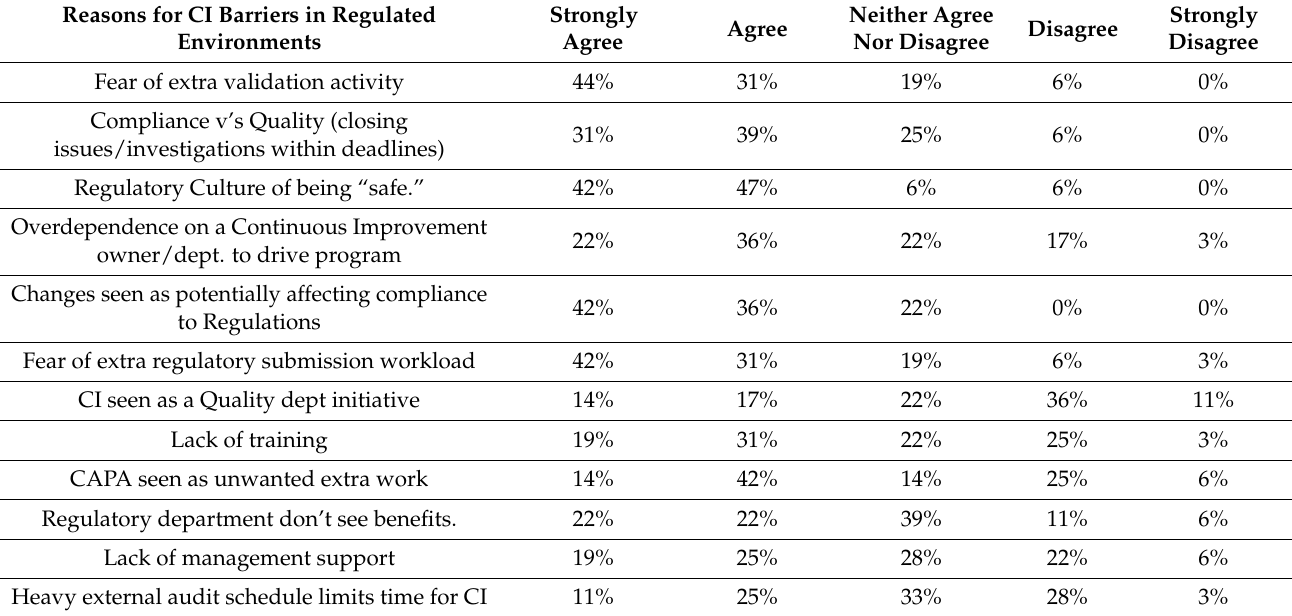
Table 5. Reasons for CI barriers in a pharma-regulated